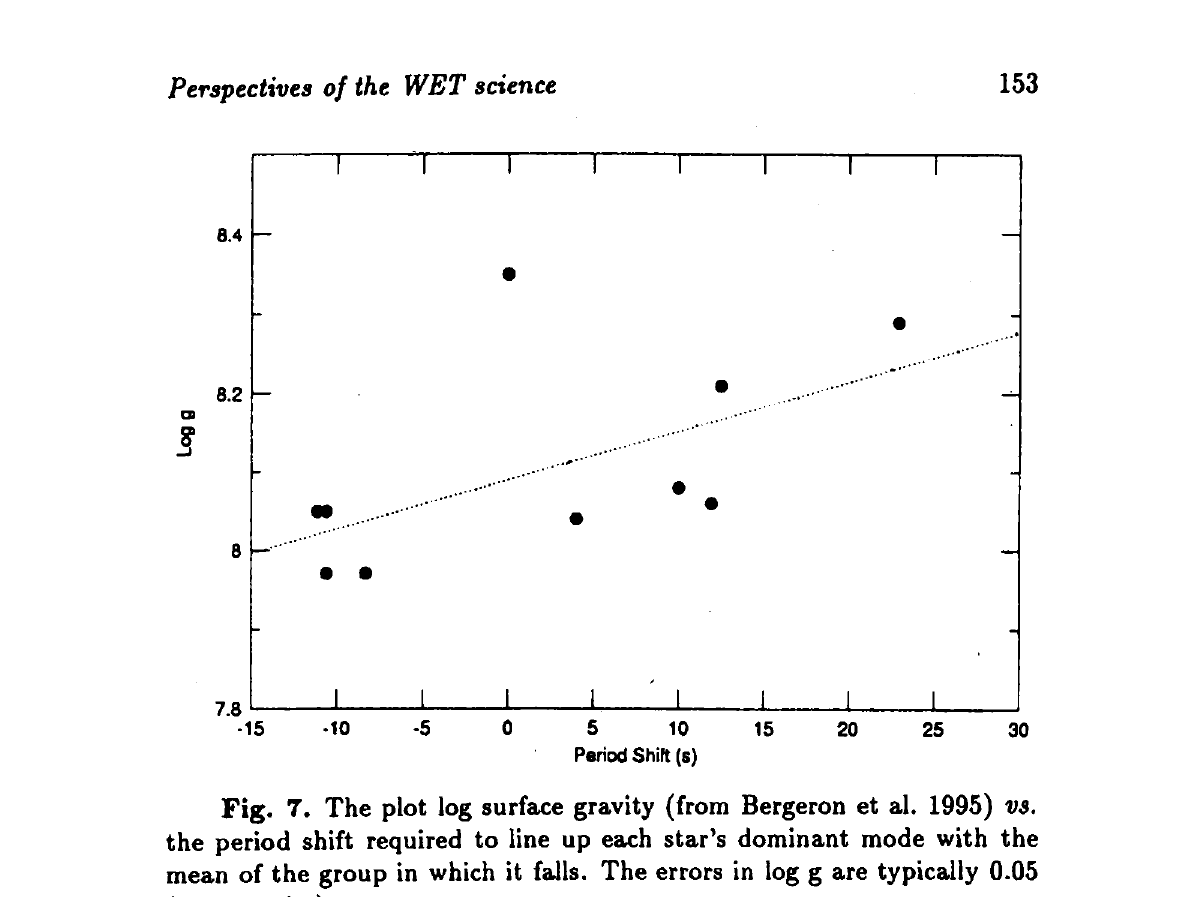
Fig. 7. The plot log surface gravity (from Bergeron et al. 1995) vs. the period shift required to line up each star's dominant mode with the mean of the group in which it falls. The errors in log g are typically 0.05 (in cgs